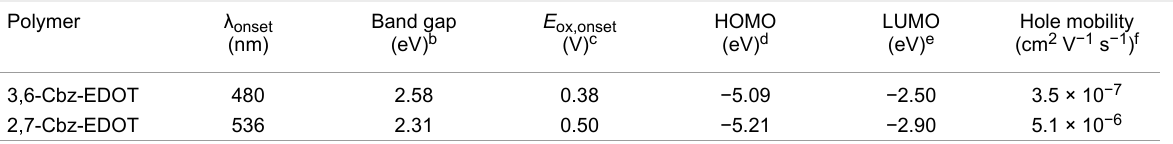
Table 1: Optical, electrochemical, and electrical properties of Cbz-EDOT polymers a . Polymer